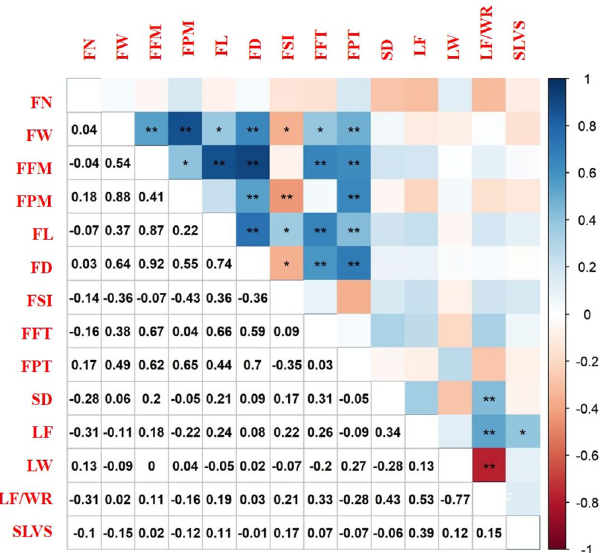
Figure 3. Linear correlation matrix (Pearson) among Psidium guajava traits obtained from 61 genotypes. UENF, municipality of Campos dos Goytacazes, 2022. Fruit number (FN); Fruit weight (FW); Fruit flesh mass (FFM); Fruit placental mass (FPM); Fruit length (FL); Fruit diameter (FD); Fruit shape index (FSI); Fruit flesh thickness (FFT); Fruit placental thickness (FPT); Stem diameter at 10 cm from the soil (SD); Leaf length (LF); Leaf width (LW); Leaf length/width ratio (LF/WR); Secondary leaf vein spacing (SLVS).